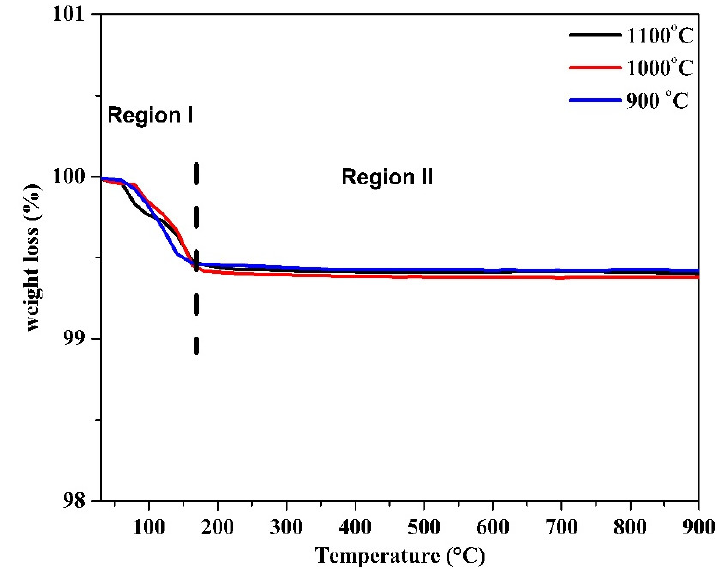
Figure 3. TGA curves for sintered BaCe 0.2 Zr 0.6 Y 0.2 O 3−δ electrolyte .